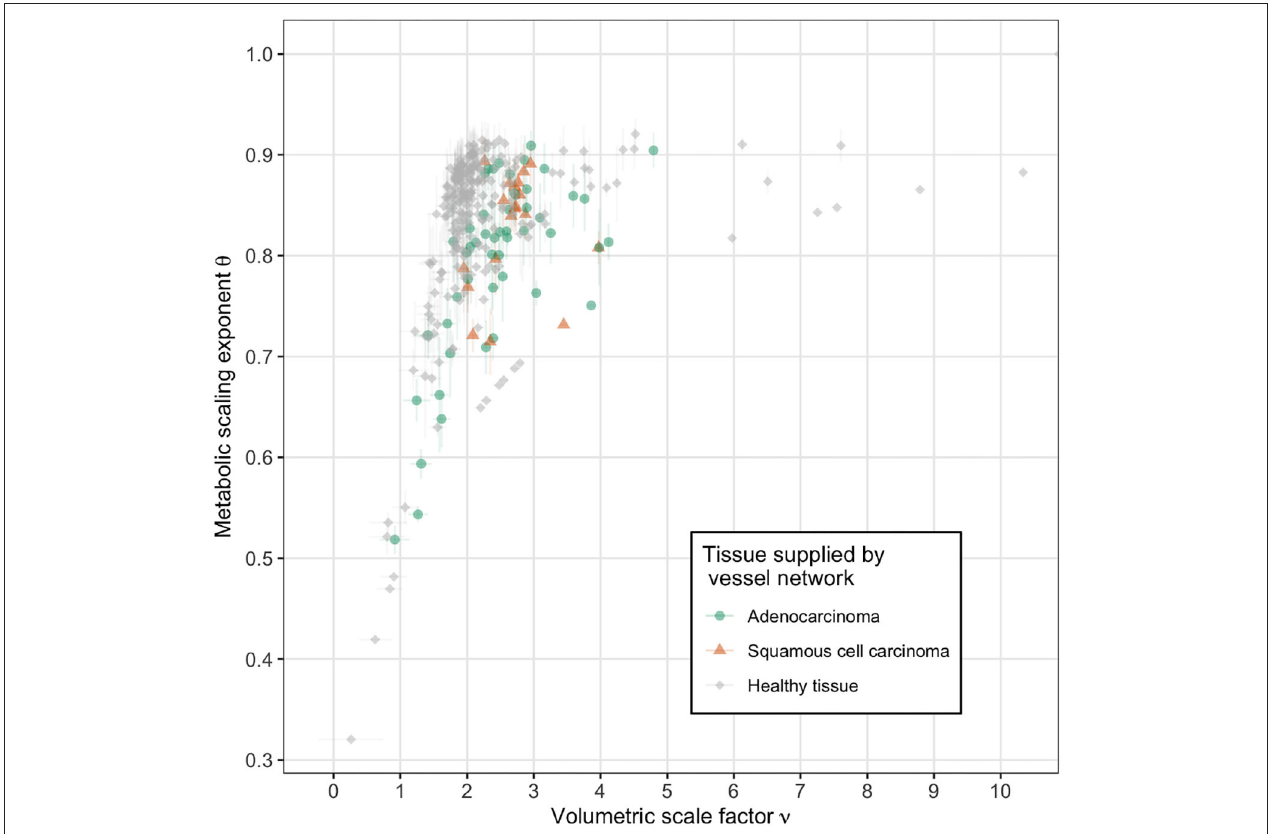
FIGURE 7 | Vascular based estimates of metabolic scaling exponents as a function of volumetric scale factor for tumor supplying vessel networks (adenocarcinoma in green and squamous cell carcinoma in orange) and healthy tissue supplying vessel networks (gray). The direction of increasing network size, as measured by generation number N , is into the upper left corner. Note the distinct clustering of the healthy tissue supplying networks along ν ≈ 2 and the tumor supplying networks along ν >